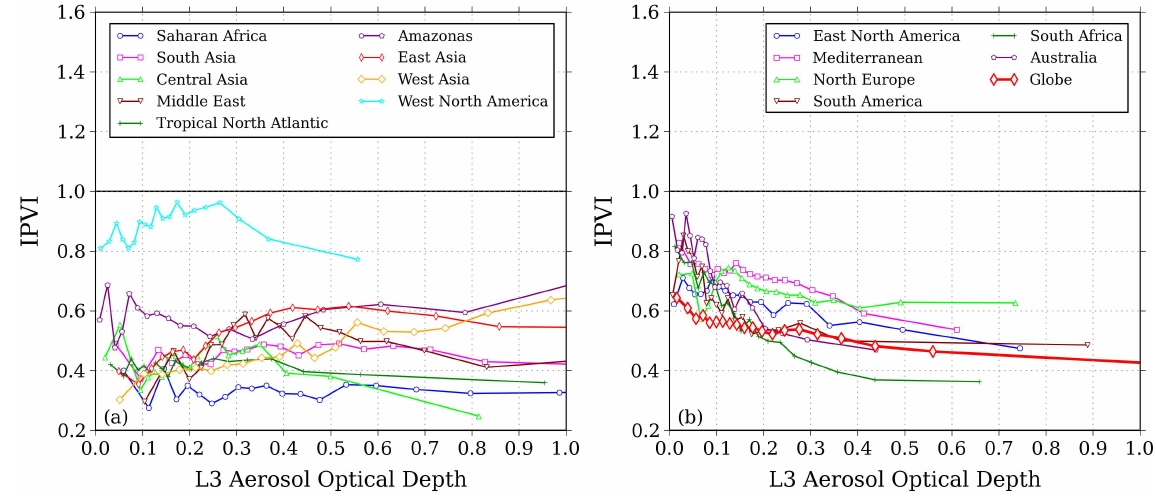
Fig. 7. Intra-pixel variability index (IPVI), defined as the ratio of the standard deviation of the intra-pixel L2 AOD values, σ s , provided as part of the L3 AOD product, to the standard deviation of the L3 AOD error as compared to ground AERONET measurements, σ ε (Sect. 3.3); (a) regions with relatively stable IPVI and, (b) regions with decreasing IPVI for increasing L3 AOD.